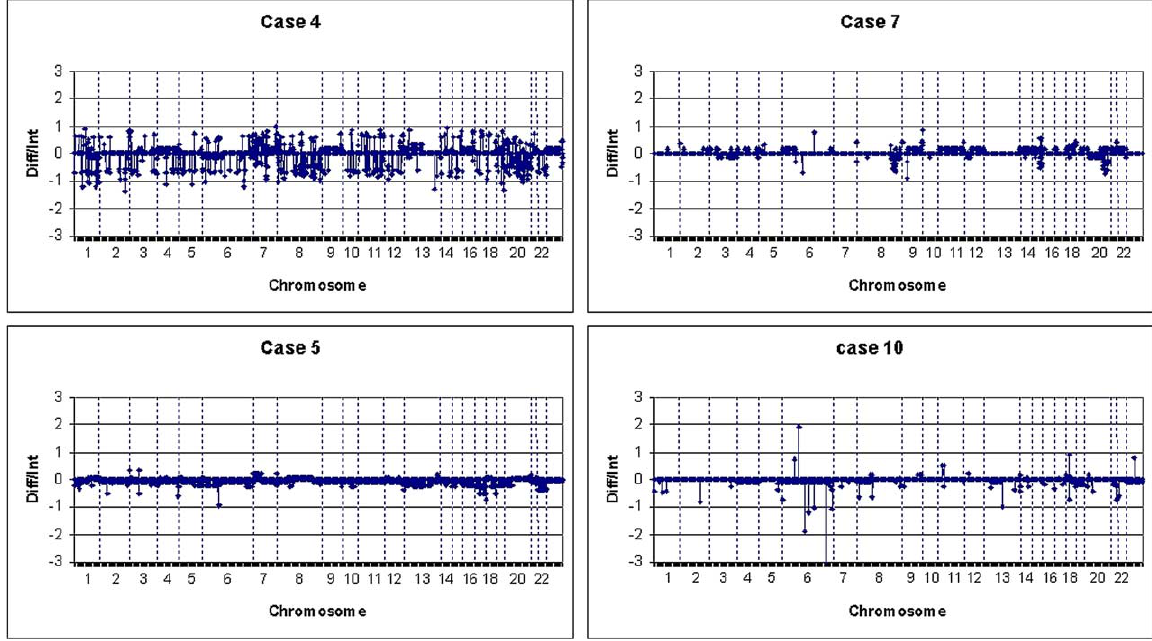
Fig. 4. Examples of ratios between diffuse and intestinal components within the same tumour (Log2 ratio Diffuse – Log2 ratio Intestinal). Dashed-vertical lines – transition between chromosomes.